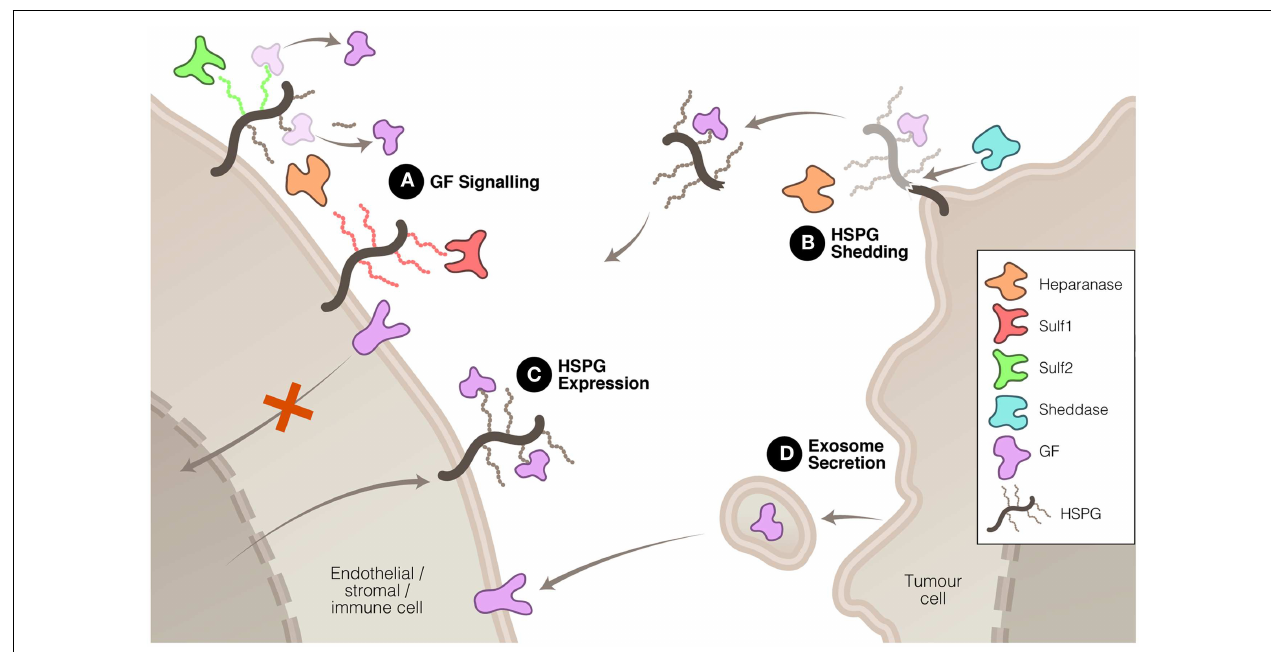
sheddases, can stimulate HSPG shedding, dispersing autocrine to paracrine signaling. (C) Heparanase and Sulf2 can up-regulate HSPG expression to promote GF signaling. And (D) heparanase can induce exosome secretion allowing tumor cell communication with neighboring